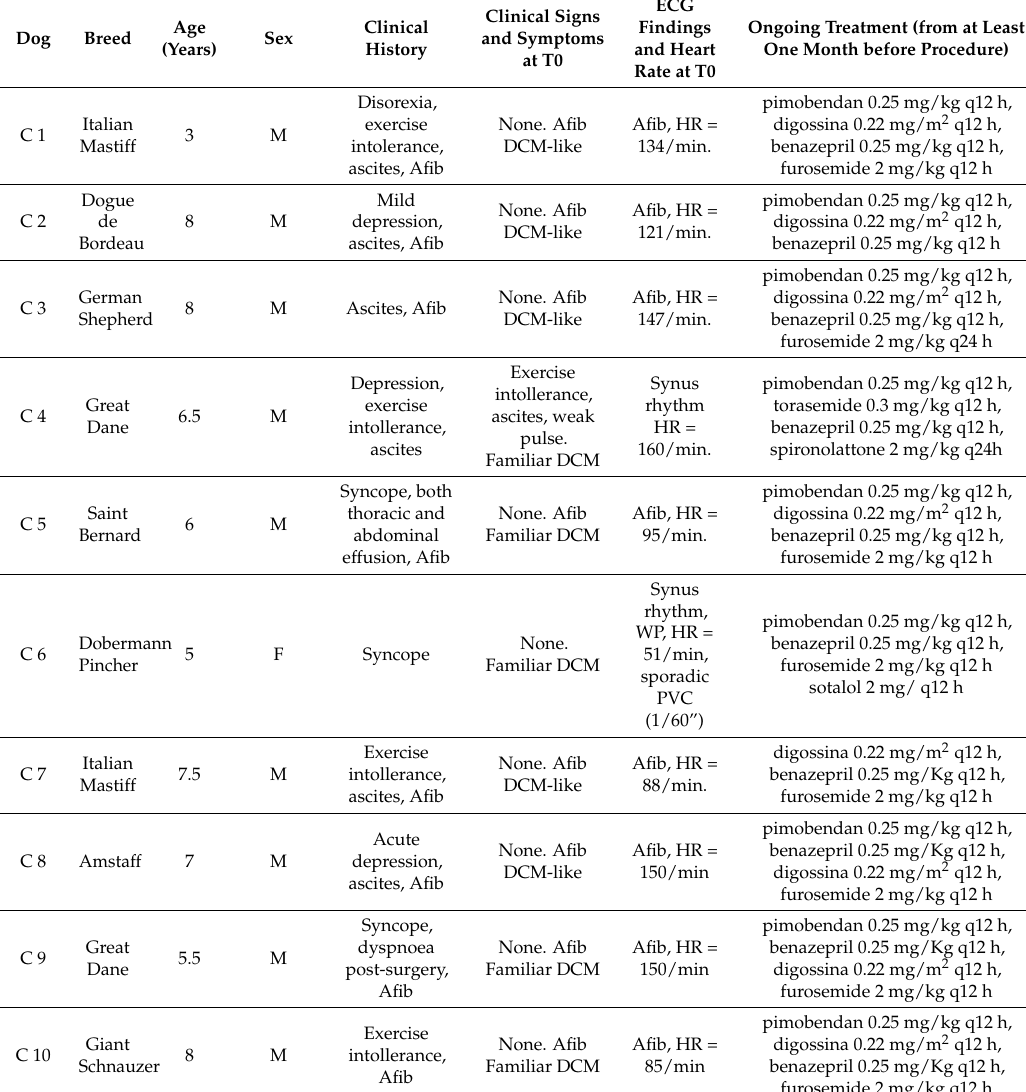
Table 1. Signalment and clinical history of enrolled dogs. Clinical signs, cardiac rhythm, heart rate and standard treatment ongoing at time of procedure (T0) are reported for each dog included in the study.